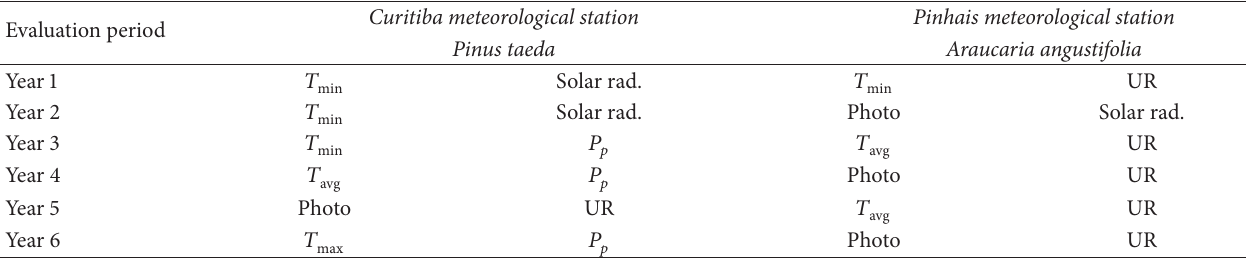
Table 3: Climate variables selected by principal component analysis for the six-year study from the Curitiba and Pinhais meteorological stations.